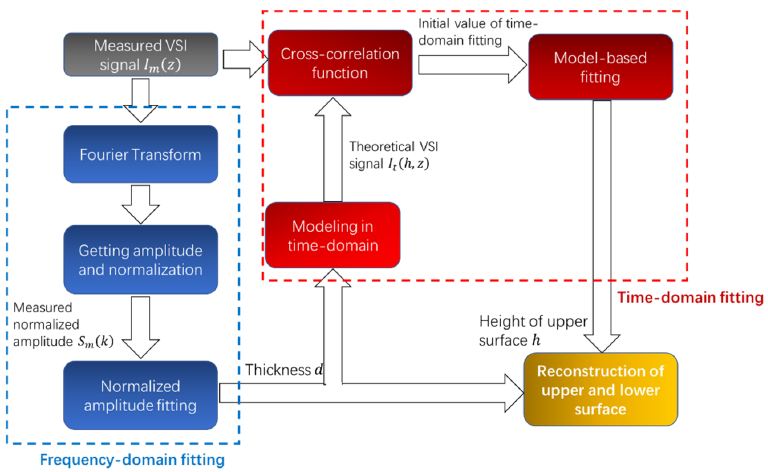
Figure 2. Measurement process for the proposed method.